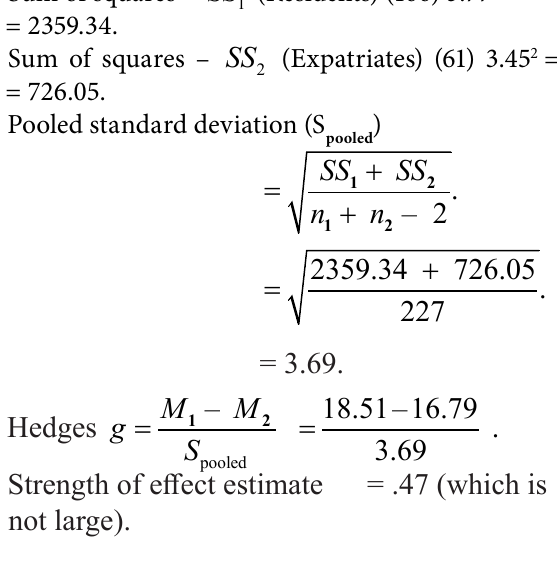
Table 3. Correlation between demographics and Orientation towards